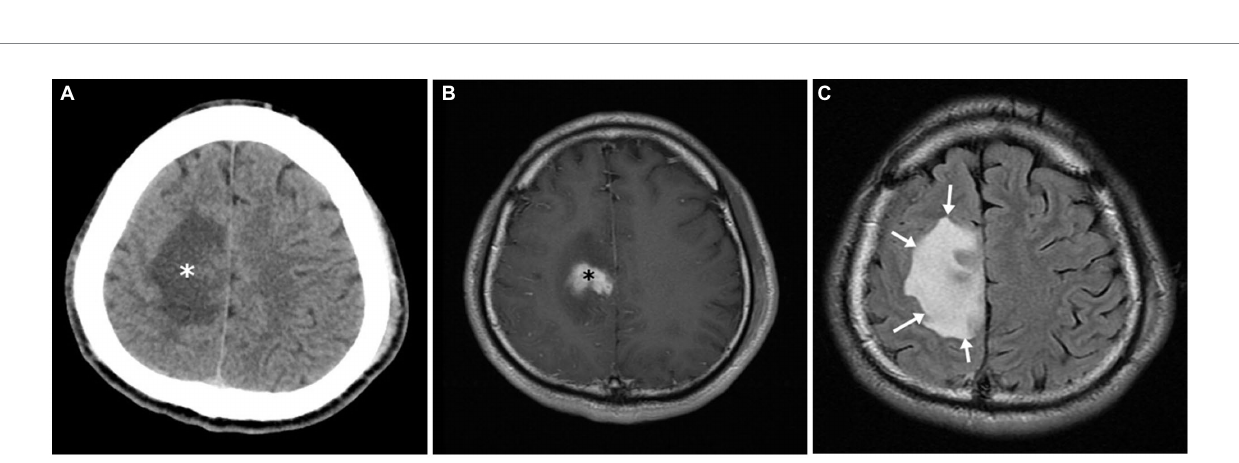
FIGURE 2 Central nervous system melioidosis of case 2. Unenhanced computed tomography (CT) showed a low attenuation in right frontal lobe (white asterisk) (A) . Magnetic resonance (MR) images of the corresponding region depicted hyperintensity in the T2 weighted fluid attenuated inversion recovery (FLAIR) sequence (white arrows) (B) and an enhancing soft tissue lesion in the post contrast T1 weighted images (black asterisk) (C) . All image findings are compatible with encephalitis.